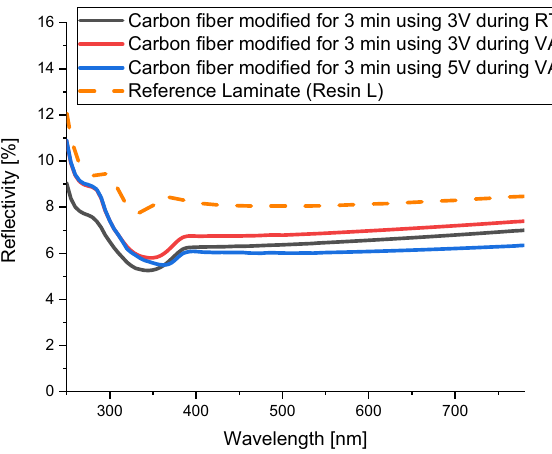
Figure 16: Comparison between variations in the manufucturing processes RTM and VARI after depositing CNTs on the AS4 carbon fi ber.